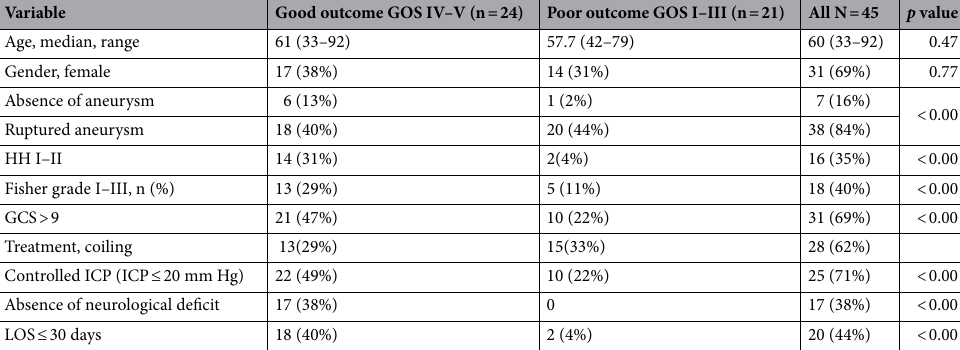
Table 1. Summary of characteristics of the 45 patients with SAH. GOS, Glasgow Outcome scale at 3 months; HH, Hunt Hess scale; GCS, Glasgow Coma Scale; ICP, intracranial pressure; LOS, hospital length of stay.